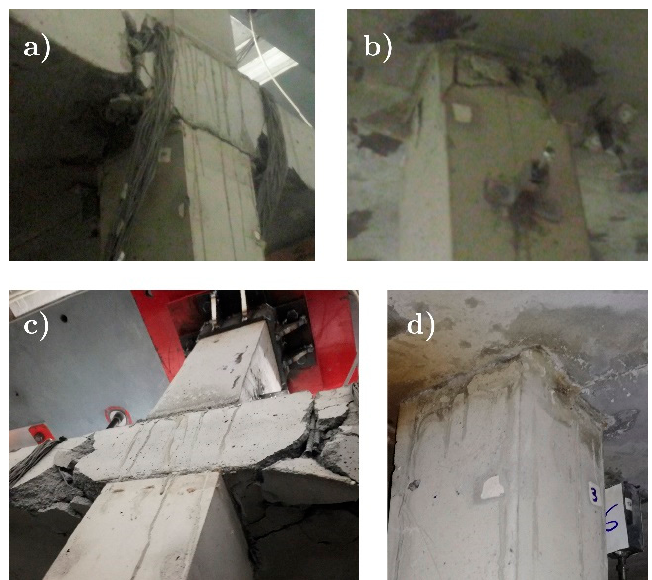
Figure 11. Final damage at the column-plate connections: a) ESH (BS1), b) ISH (BS1), c) ESH (BS2) and 278 d) ISH (BS2). 279